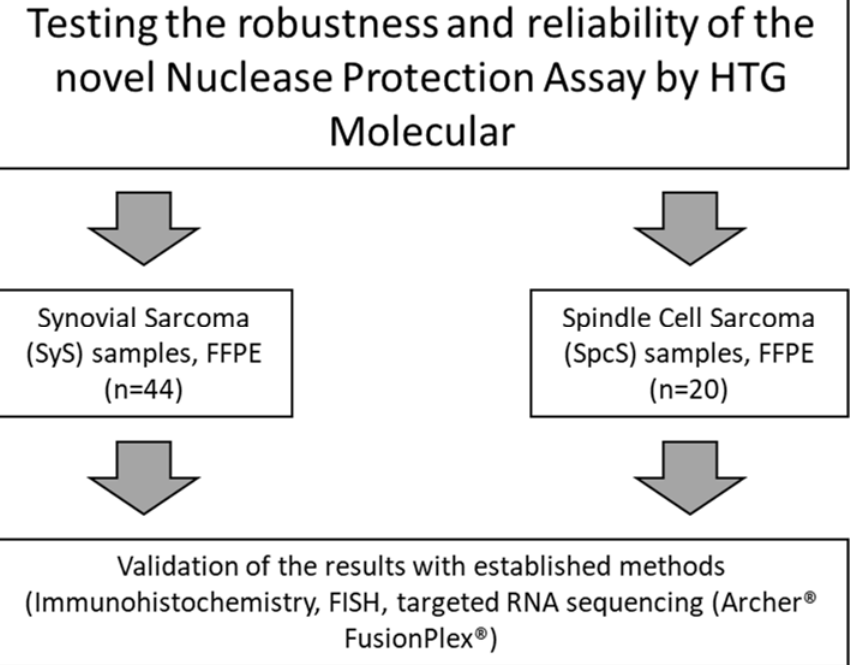
Figure 1. Study design. The robustness and reliability of the novel nuclease protection assay by HTG Molecular was tested on FFPE samples of 44 SyS and 20 SpcS patients. Samples were validated with results from established methods: immunohistochemistry, fluorescence in situ hybridization as well as targeted RNA sequencing (Archer ® FusionPlex ® ).